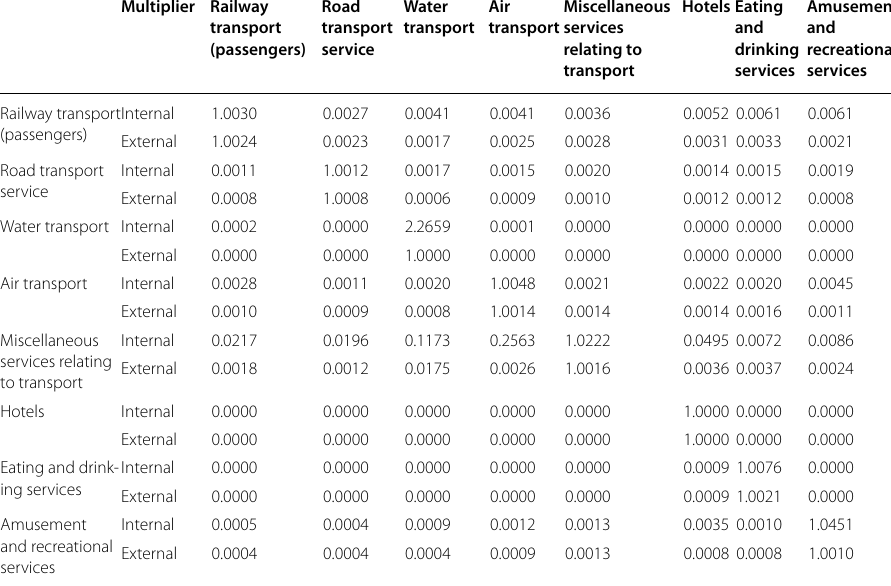
Source: Author’s calculation based on Tokyo Metropolitan Government